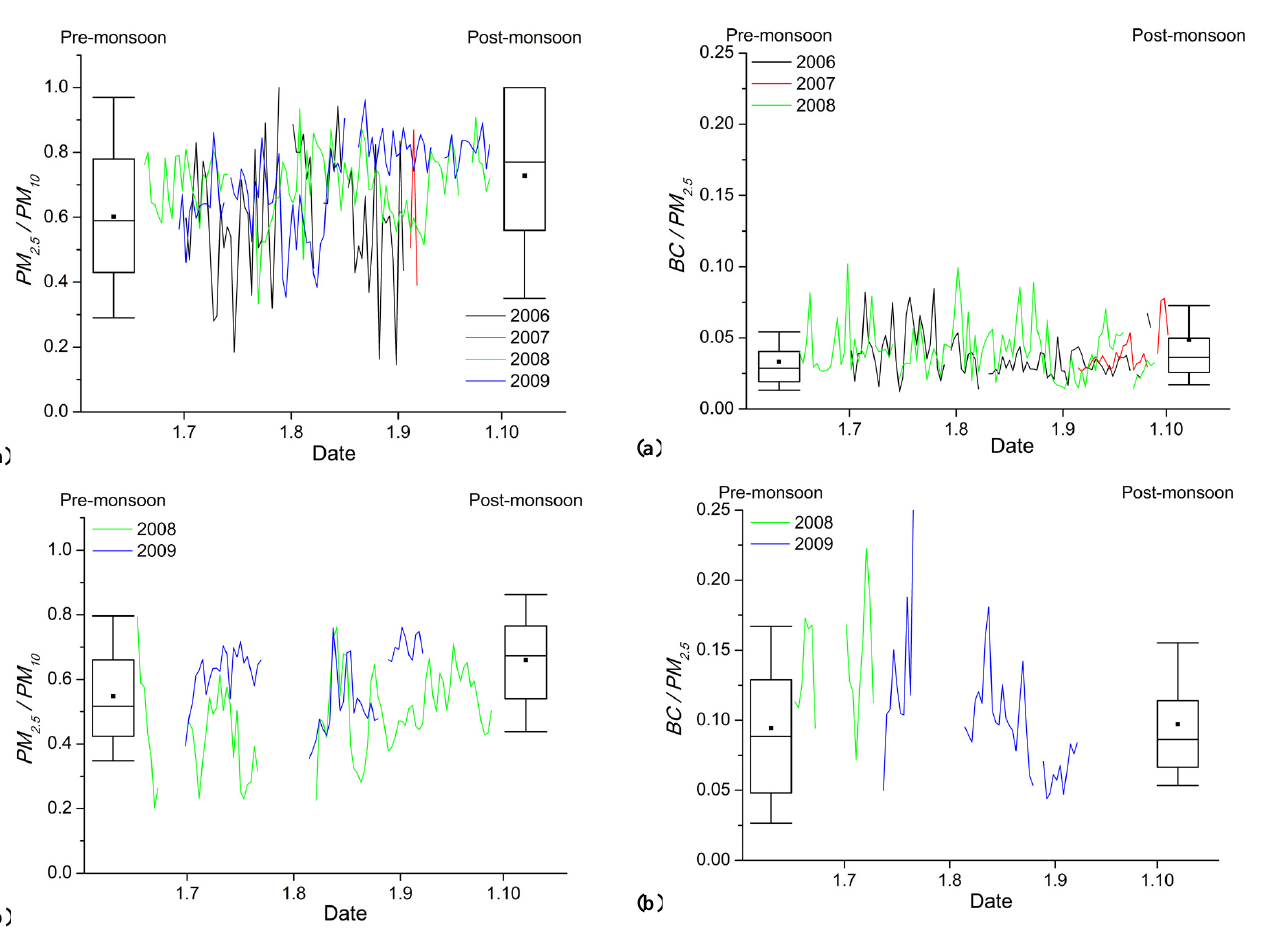
Fig. 9. Fraction of PM 2 . 5 in PM 10 mass. (a) Mukteshwar (b) Gual Pahari. Lines are 24h running averages from the monsoon season, box plots denote to the pre- and post-monsoon seasonal values of 10%-ile, 25%-ile, median (line), average (dot), 75%-ile, and 90%- ile.